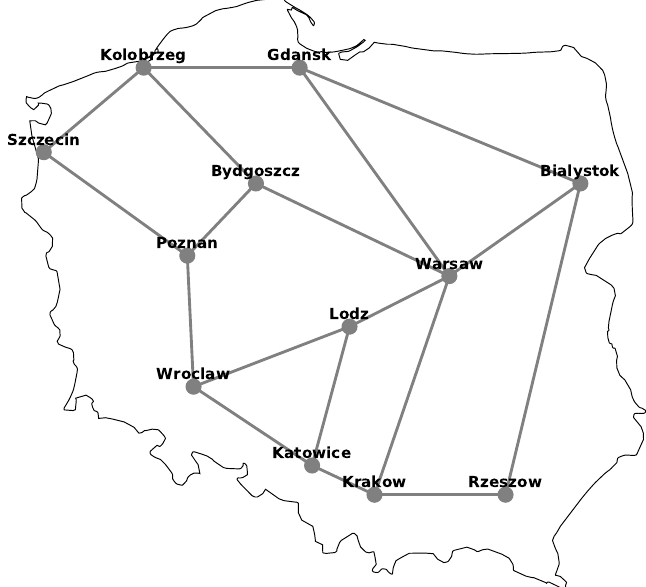
Figure 3. Schematic diagram of Polish national transmission optical backbone